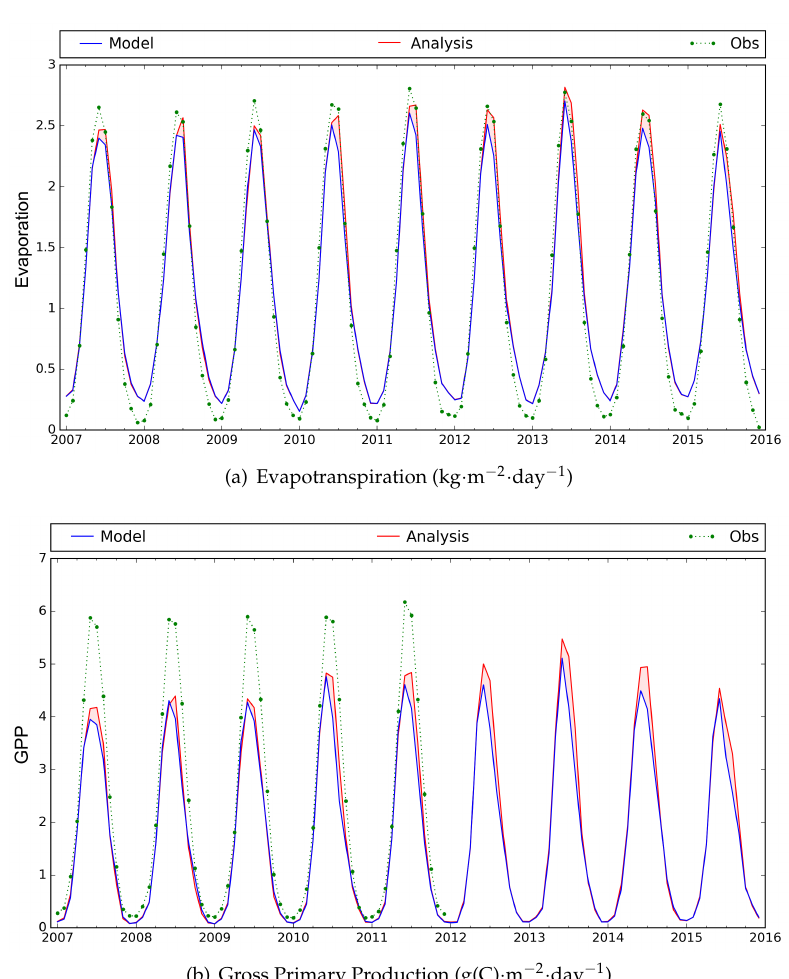
Figure 4. Monthly time series of the products (green), open-loop (blue) and analysis (red) simulations from 2007 to 2015 averaged over the Euro-Mediterranean area for: ( a ) evapotranspiration; ( b ) gross primary production (observations only until